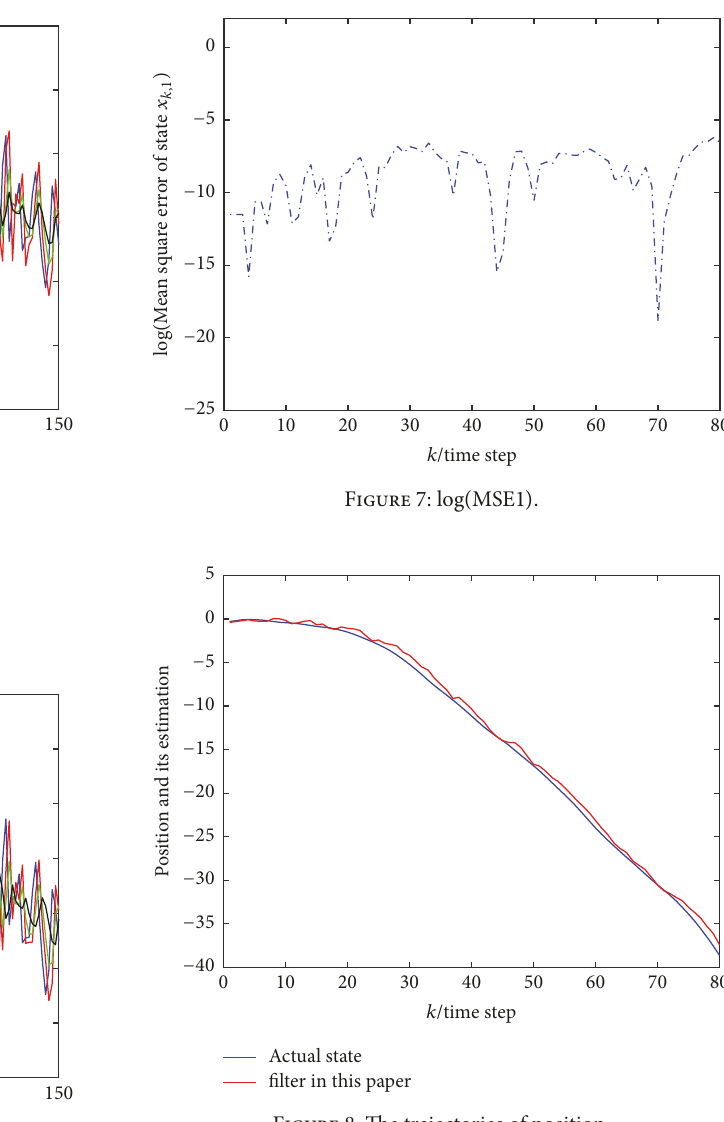
Figure 8: The trajectories of